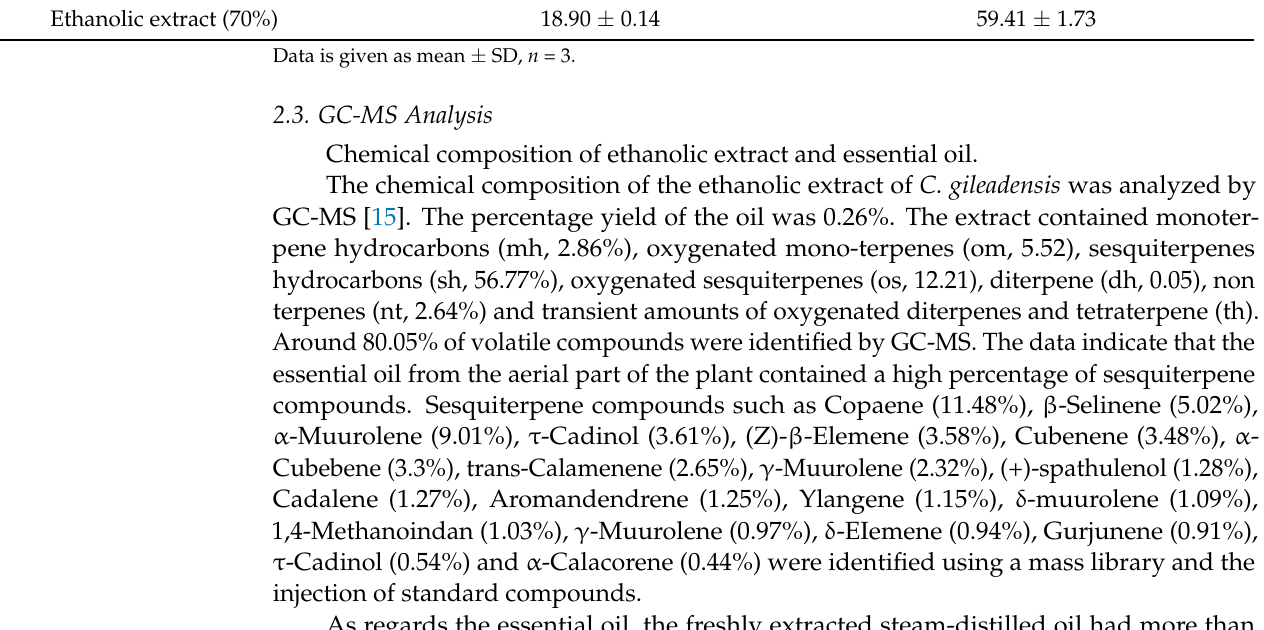
Table 3. Total phenolics and flavonoids in ethanolic extracts of C. gileadensis . Sample Total Phenolics (mg GAE/g Extract) Ethanolic extract